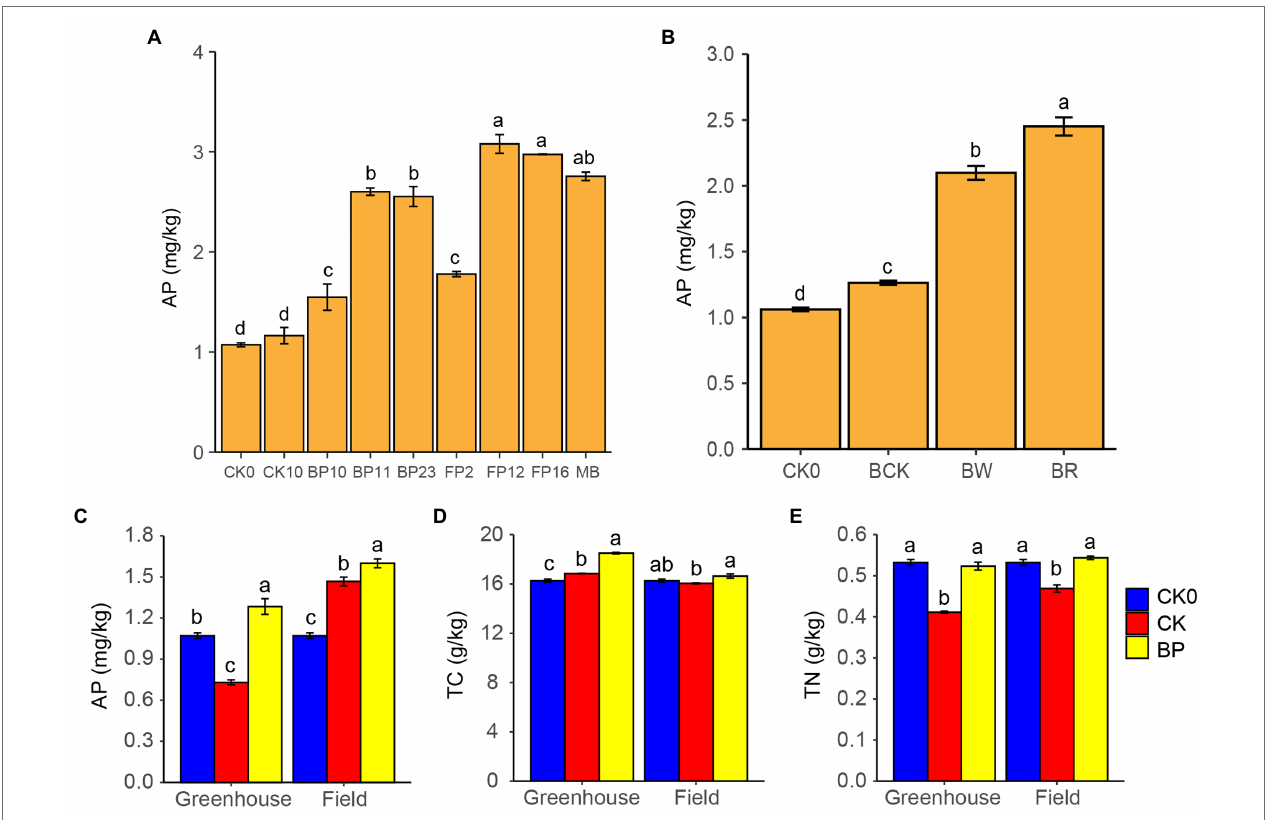
FIGURE 5 | Phosphate-solubilizing bacteria application potential. (A) AP in the barren rocky soil after treatment by phosphate-solubilizing bacteria, CK0, control group 0 day; CK10, control group 10 days; MB, mixed phosphate-solubilizing bacteria. (B) Effect of sweetpotato root exudates on phosphate-solubilizing, CK0, control group 0 day; BCK, control group without mixed phosphate-solubilizing bacteria 10 days; BW, mixed phosphate-solubilizing bacteria with sterile water; BR, mixed phosphate-solubilizing bacteria with sweetpotato root exudates. (C-E) Soil properties in greenhouse and field pot experiments, AP, available phosphorus; TC, total carbon; TN, total nitrogen; CK0 group, control group 0 day; CK group, control group without phosphate-solubilizing bacteria 100 days; and BP group, mixed phosphate-solubilizing bacteria was applied 100 days. Different letters denote significant difference from a Tukey’s HSD test ( p <